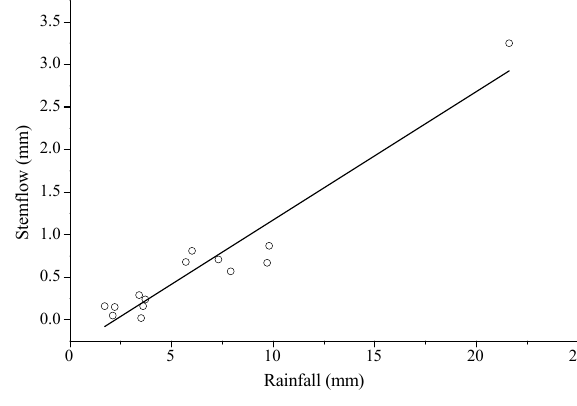
Fig. 3. Relationship between individual rainfall and stemflow for C. korshinskii .